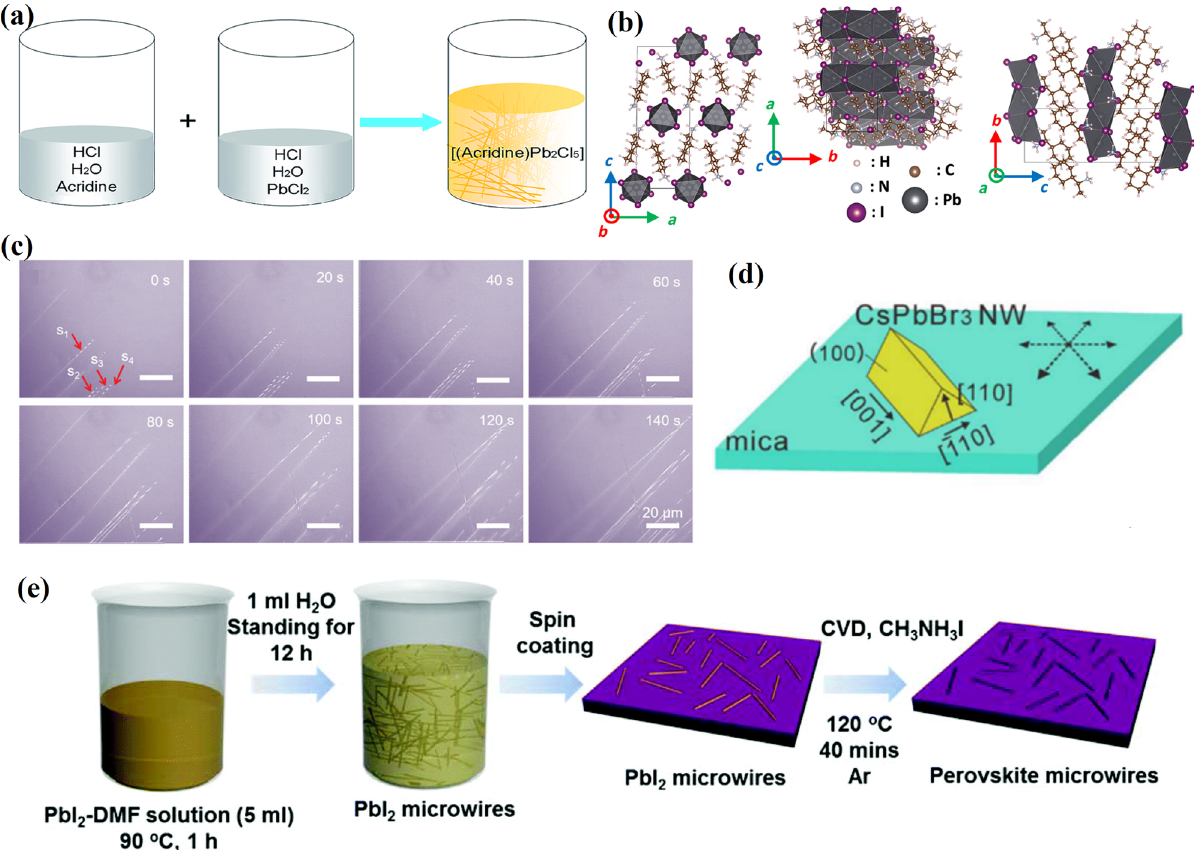
Figure 4: ( a ) The facile synthesis process of organic – inorganic hybrid perovskite - AD crystals in aqueous solution at room temperature, reproduced with permission from ref. [ 64 ] . Copyright 2019, The Royal Society of Chemistry. ( b ) A diagram of the structure of the 1D perovskite, reproduced with permission from ref. [ 65 ] . Copyright 2020, American Association for the Advancement of Science. ( c ) Optical microscope photograph for in situ monitoring wire growth, reproduced with permission from ref. [ 67 ] . Copyright 2021, Wiley - VCH. ( d ) A schematic illustration of the epitaxial growth of CsPbBr 3 NWs on mica, reproduced with permission from ref. [ 68 ] . Copyright 2017, American Chemical Society. ( e ) Schematic of the solution process to fabricate PbI 2 microwires and the vapor phase conversion process to transfer PbI 2 into hybrid perovskite NWs, reproduced with permission from ref. [ 70 ] . Copyright 2016, The Royal Society of